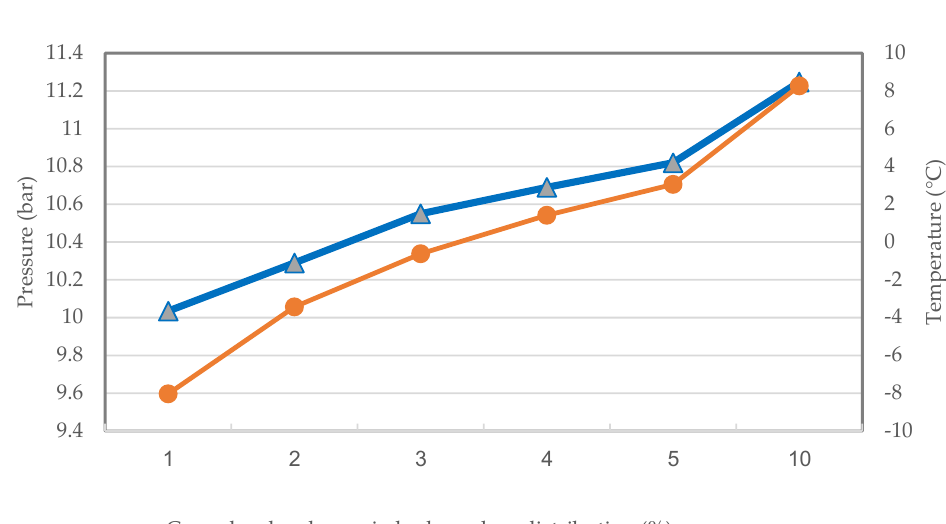
Figure 7. Results of C 9 – C 19 data analysis of Esenyurt RM-A natural gas station.